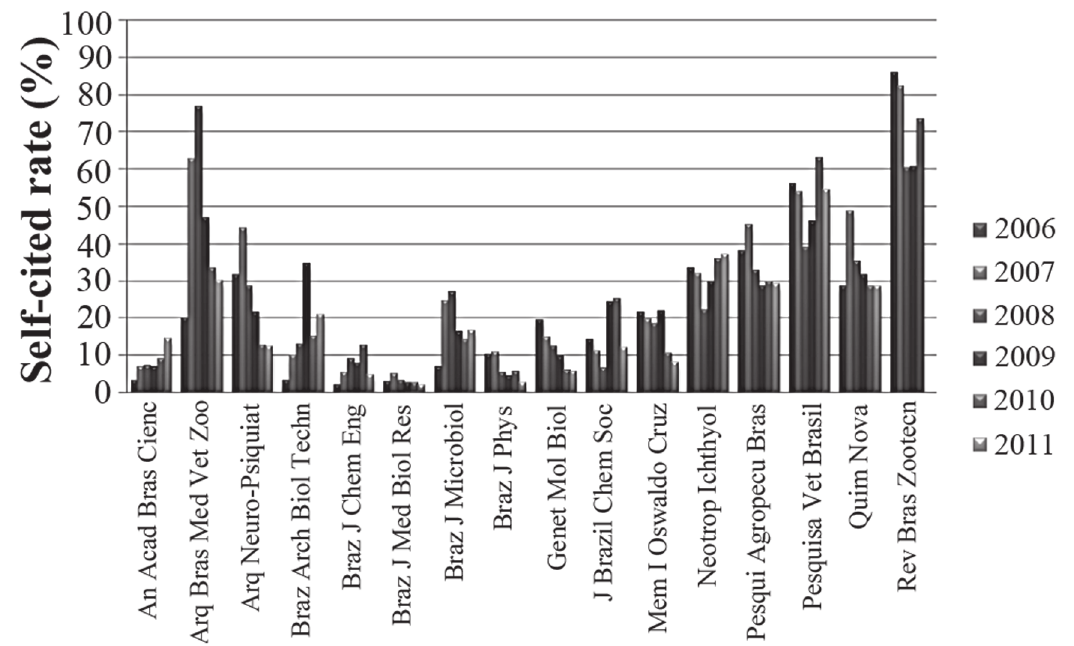
Fig. 1. Brazilian journals and their corresponding self-cited rates between 2006 and 2011.